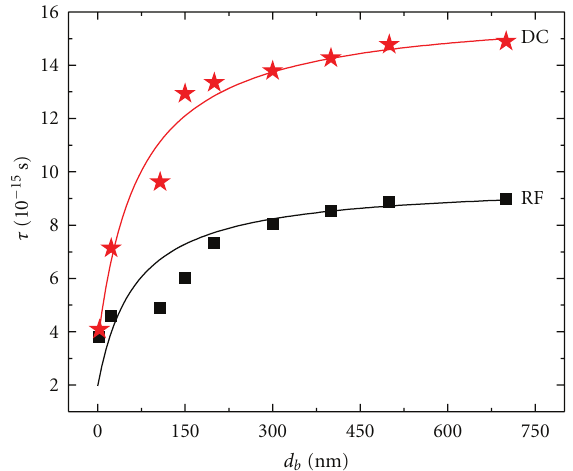
Figure 8: A comparison of the imaginary parts of the dielectric function for 3.3 nm thick Mo films deposited by rf and dc sputtering at 10mTorr.